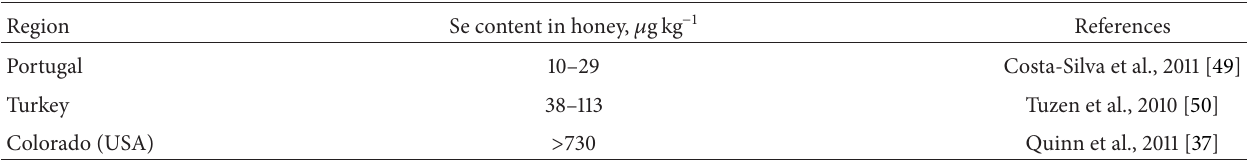
Table 2: Selenium content in honey from different